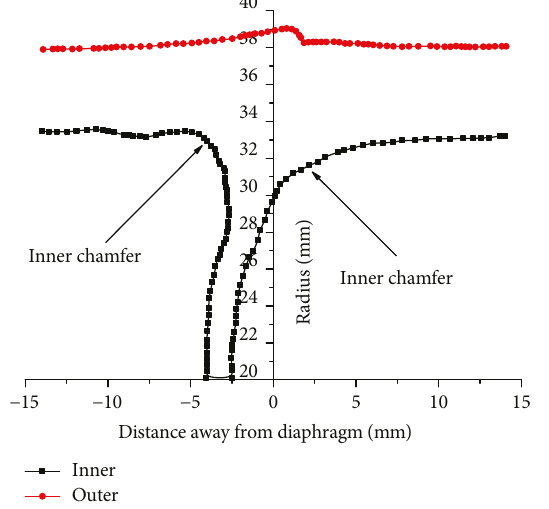
Figure 12: The outer and inner radii taken from a longitudinal section of the culm.